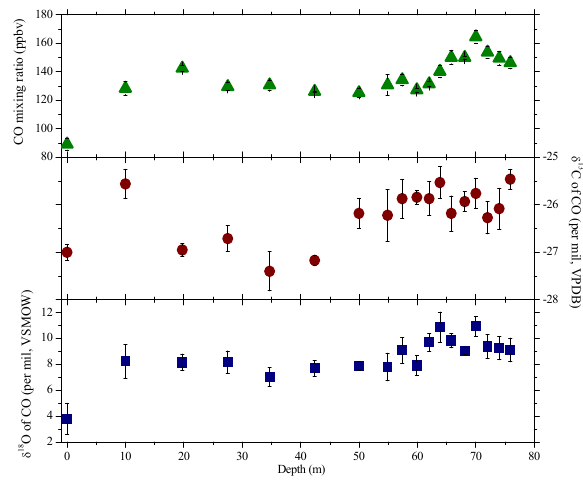
Fig. 1. Observations for the mixing ratio and isotopic ratios of CO in NEEM firn air collected from the EU 2008 borehole. Top panel: [CO] in this study (triangles); middle panel: δ 13 C of CO in this study (circles); bottom: δ 18 O of CO in this study (squares). Error bars are ± 1 σ standard deviation on replicates of 3 to 12 measure- ments at each depth